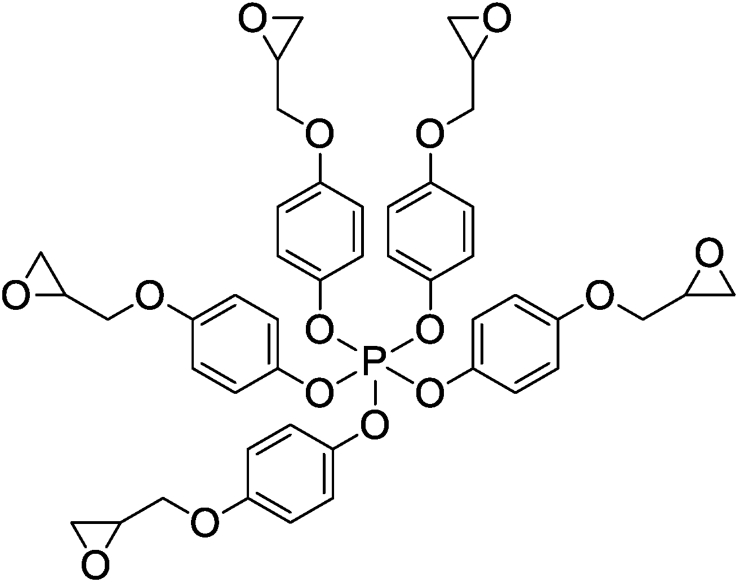
Structure of PGEPPP [25].